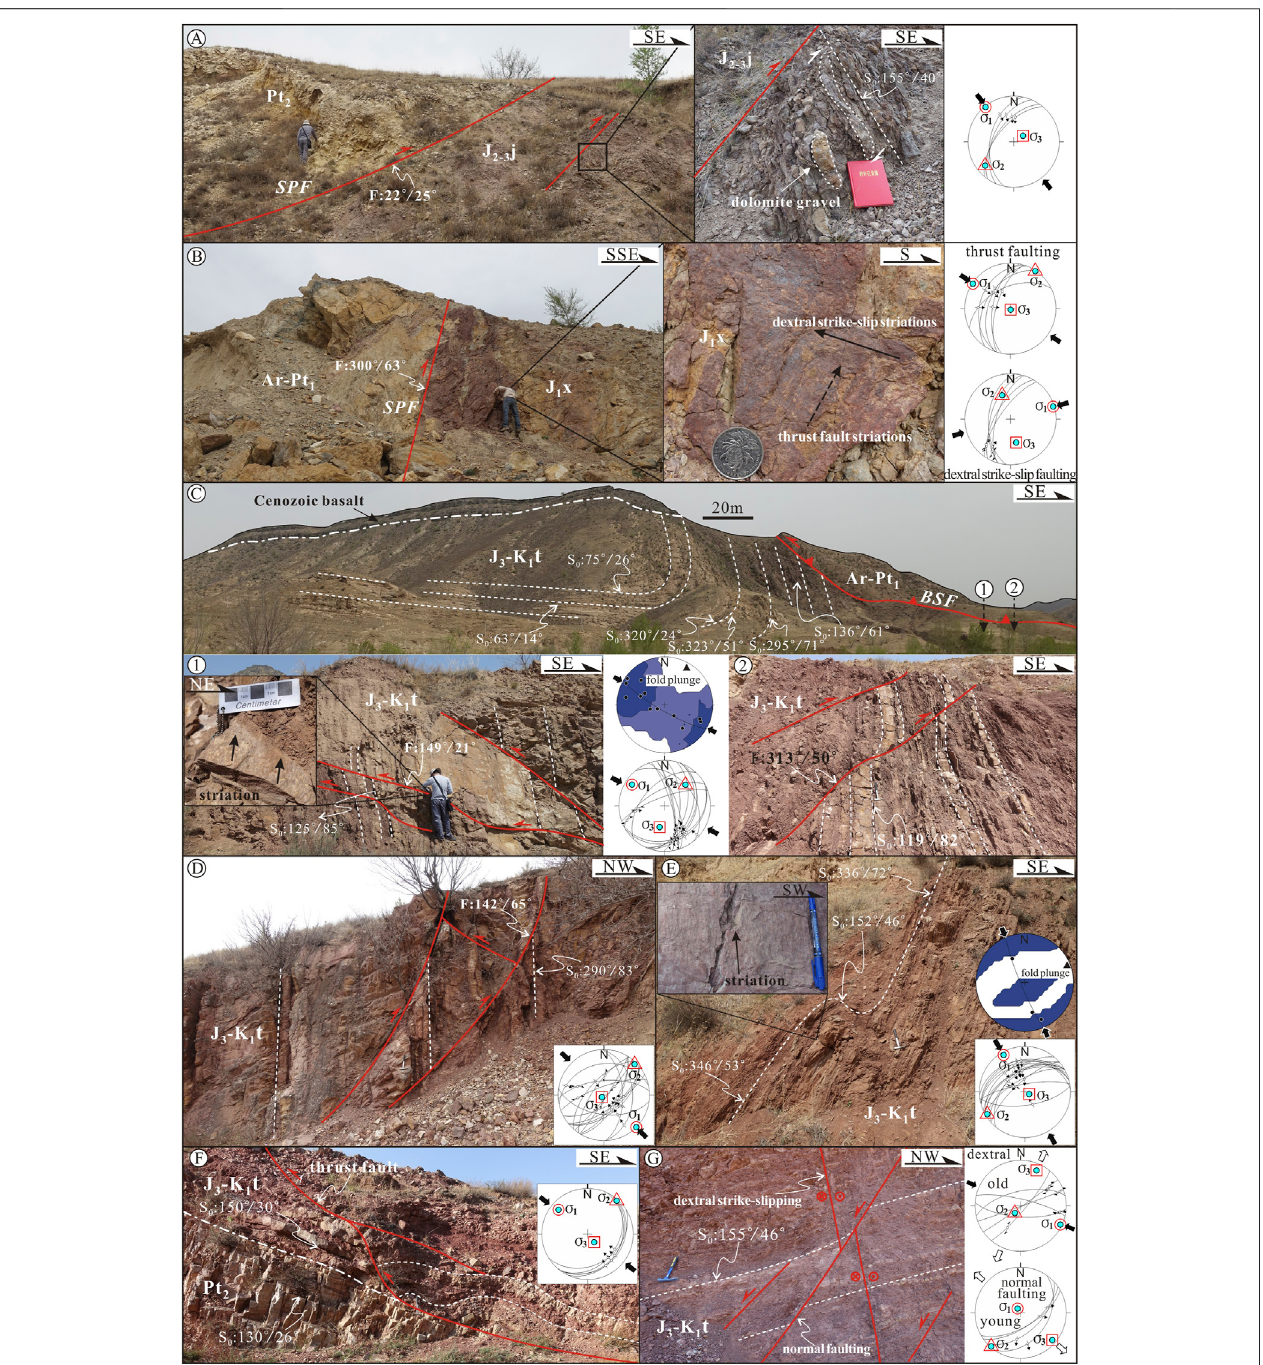
FIGURE 5 | Representative outcrop photographs related to regional NW-SE compression. (A) Mesoproterozoic carbonate rocks are overthrust southeastward over the Jiulongshan Formation along the Shangyi-Pingquan Fault (SPF) accompanied by related drag fold exposed in the footwall. (B) Two sets of striations, including dip-directionstriationswithreversefaulting andsub-horizontaldextralstrike-slipstriations,aresimultaneouslyexposedononefaultsurfaceintheXiahuayuanFormation sandstonesfrom the footwallof theSPF, correspondingto NW-SE and NE-SW compression, respectively. (C) The basement rocks are overthrust northwestward onto the Tuchengzi Formation along the Banshen-Shuiquangou Fault (BSF), accompanied with an intermediate-scale overturned syncline developed inthe footwall. (D) ApproachingtheBSF,theTuchengziFormationshownearlyupright. (E) Outcrop-scaleENE-trendingfoldaccompaniedwithinterlayerslip. (F) ASE-dippingreversefault with low dip angle has occurred along the unconformable contact between the Tuchengzi Formation conglomerates and the Mesoproterozoic quartz sandstones. (G) Two groups of faults crop out in the Tuchengzi Formation sandstones, including NE-striking dextral strike-slip and SE-dipping normal faults, corresponding to NW-SE compressionandNW-SEextension,respectively.Allthestructuralmeasurementsinthisworkwereexpressedbydipdirectionanddipangle.Lowerhemisphere,equal- area projections.